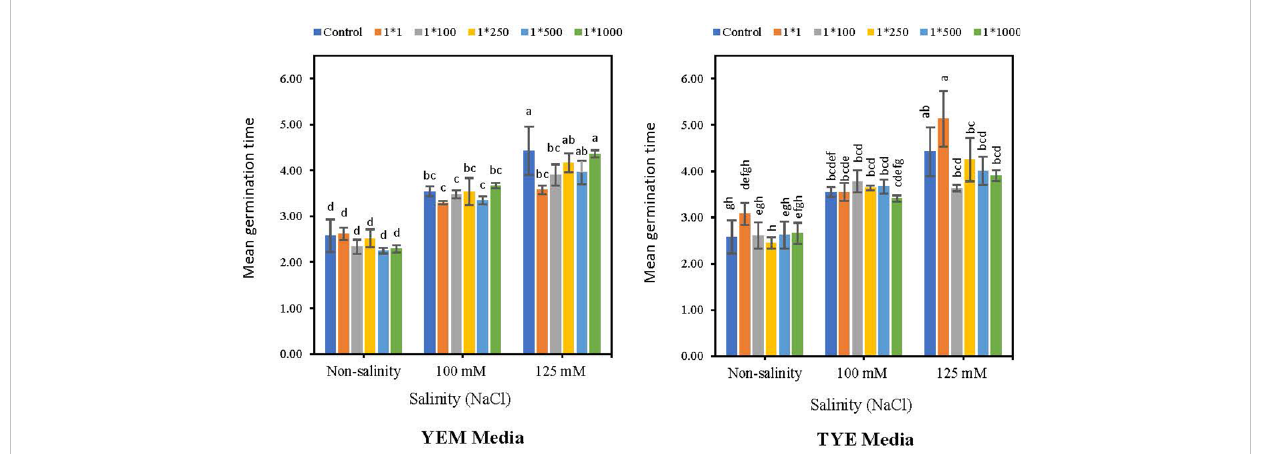
FIGURE 6 Effect of dilutions of Devosia sp. YEM(B)-CFS and TYE(B)-CFS and salinity on mean germination time (MGT) of soybean seedlings. Values represent the mean of four replicates ± SD. 1:1, 1:100, 1:250, 1:500 and 1:1000 = 1 mL Devosia sp. CFS and 1, 100, 250, 500 and 100 mL distilled water,